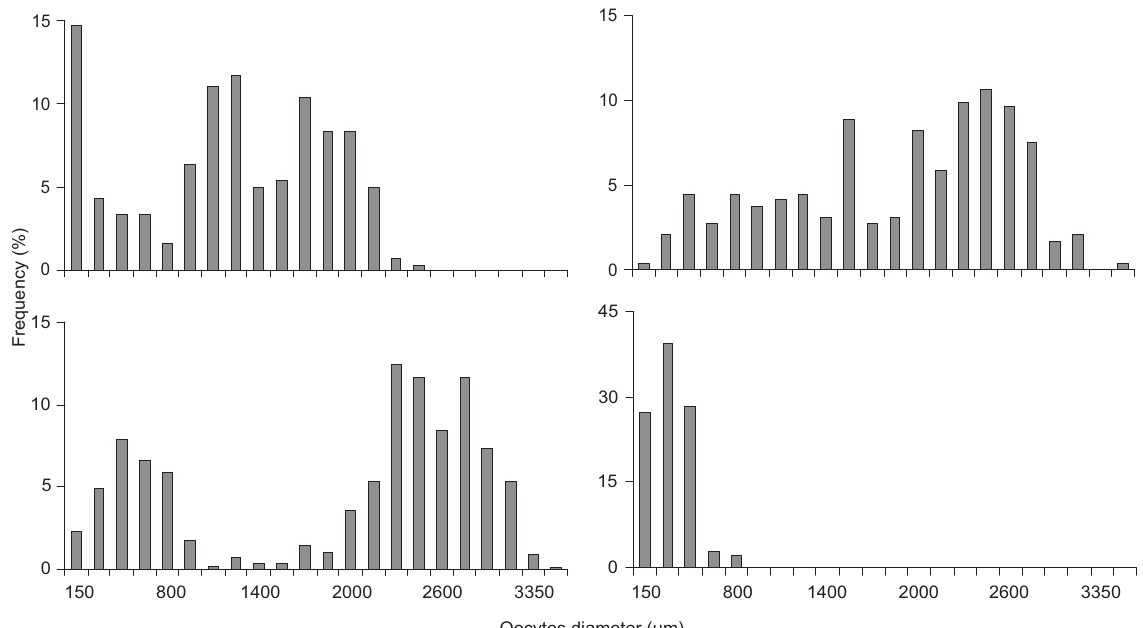
Figure 10. Diameter frequency distribution (in percentage) for oocytes of H. affinis in different stages of gonadal development. (N) Number of examined